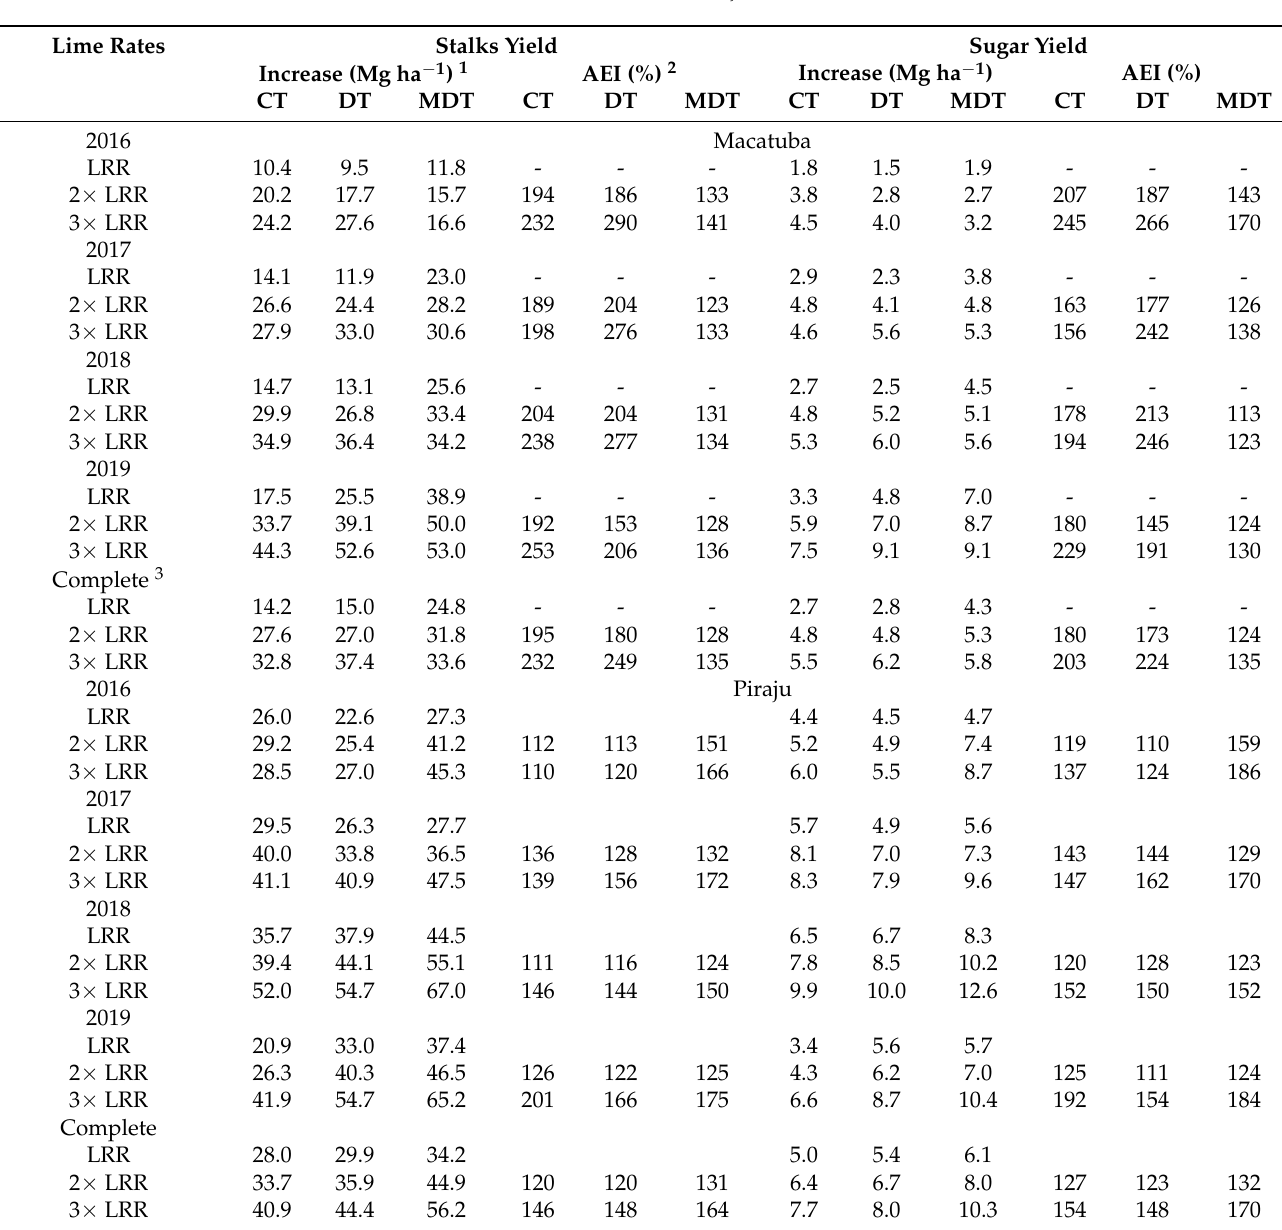
Table 1. Increments of stalk and sugar yields and agronomic efficiency index (AEI) values as a function of lime rate at Macatuba and